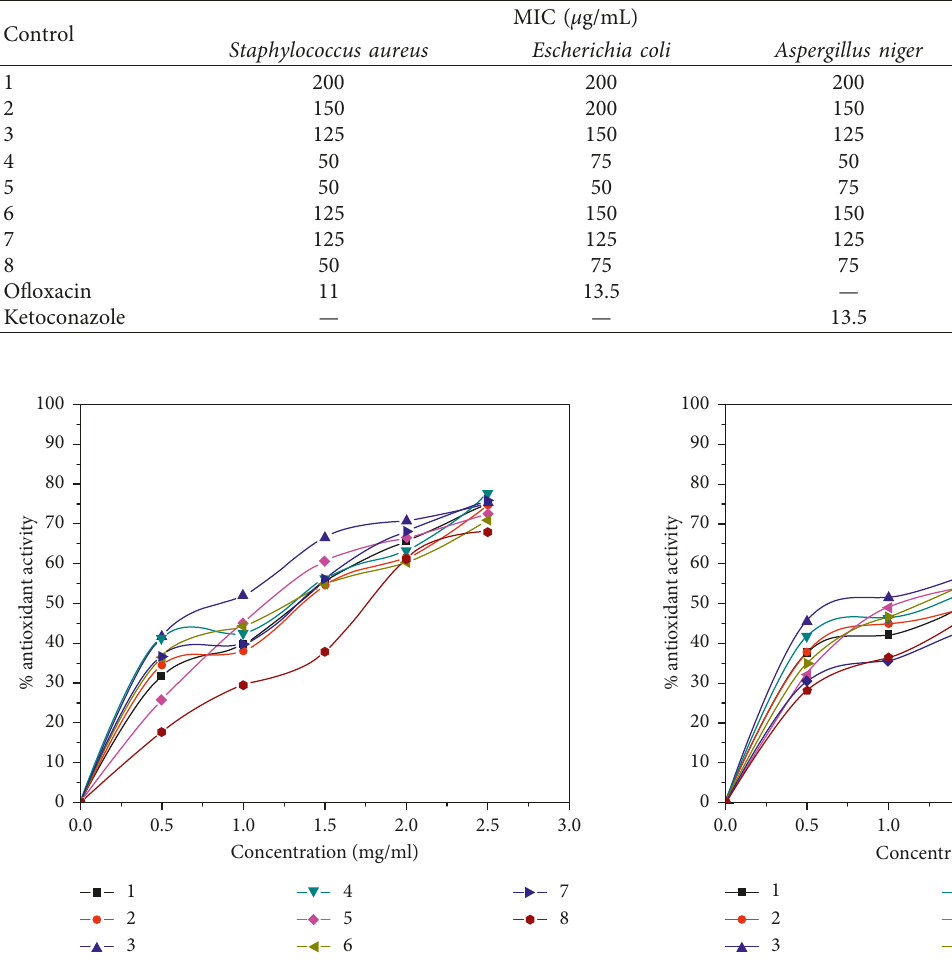
Figure 8: Hydrogen peroxide scavenging activity of the hetero- cyclic Schiff base derivatives ( 1 – 8